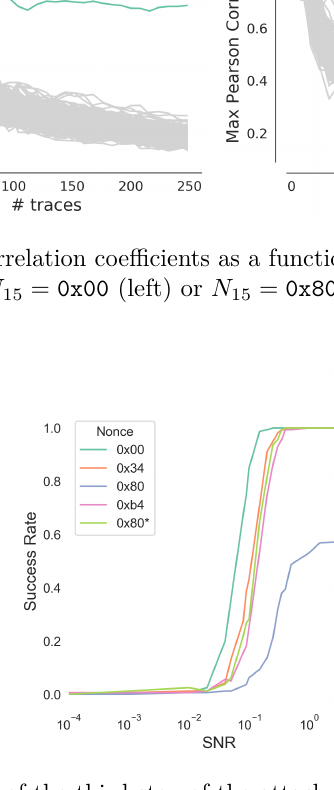
Figure 13: Success Rates of the third step of the attack for various nonces with 256 traces (except 0x80 ∗ with 128